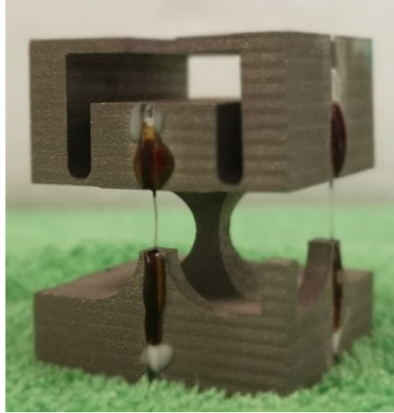
Figure 17. Physical image of three-dimensional acceleration sensor.